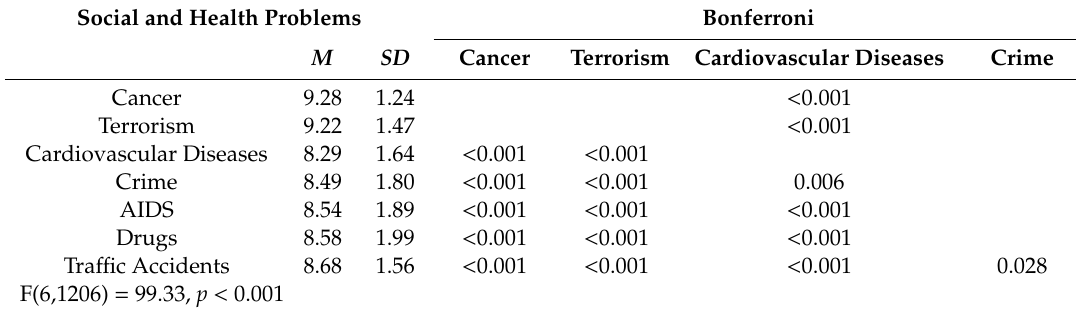
F(6,1206) = 99.33, p < 0.001